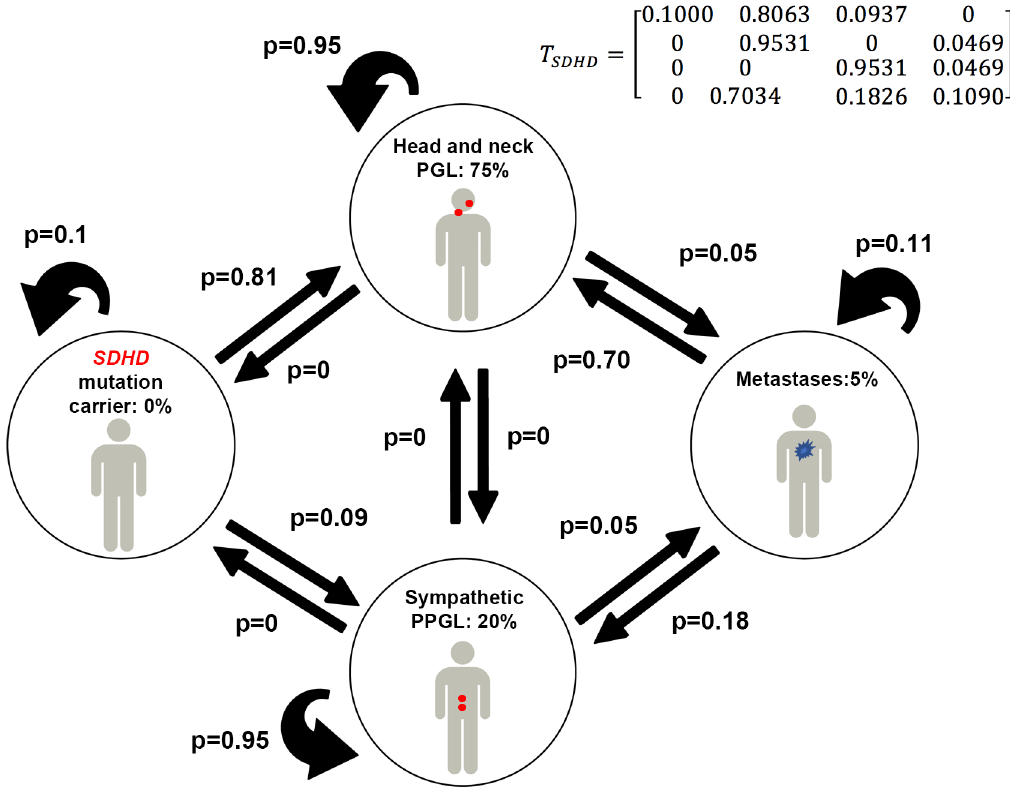
represented in a 4–4 matrix (with 4 rows and 4 columns, upper right). Numerical values for steady states and transition probabilities are displayed here and also given in Table 1 and Table 2.